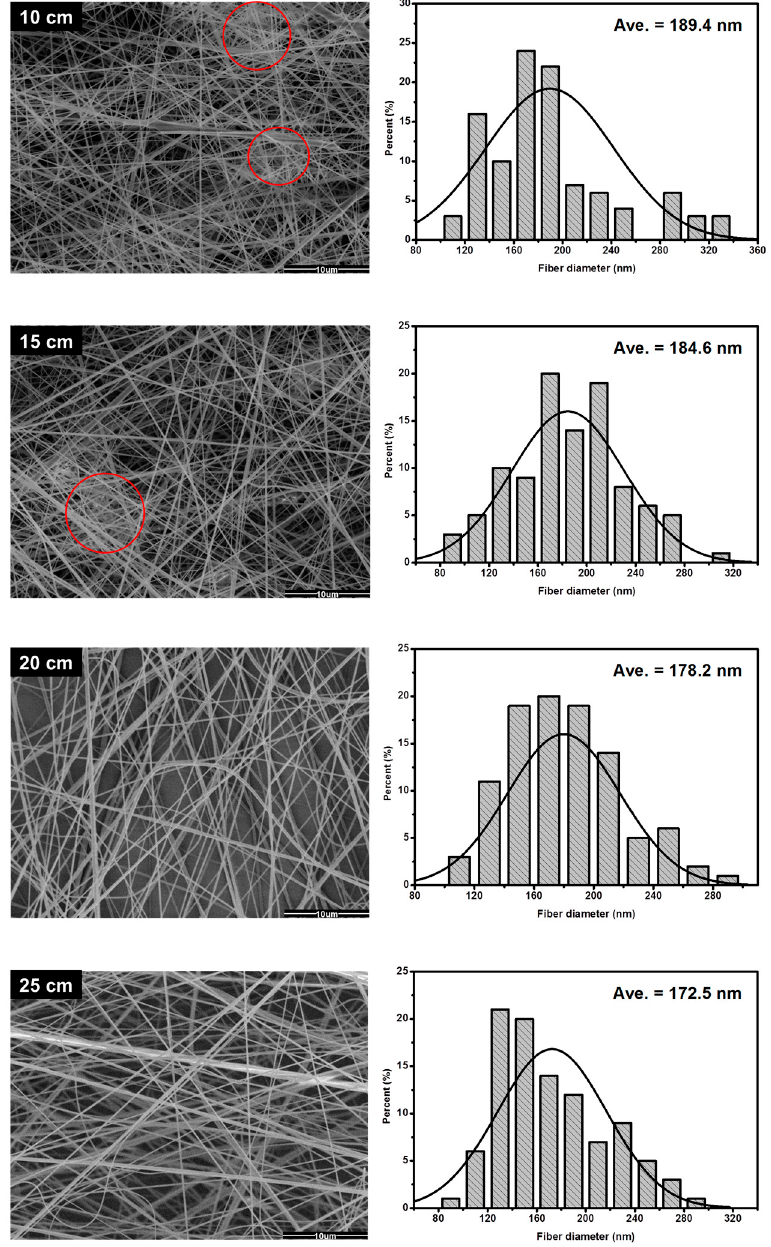
Figure 5. SEM micrographs and diameter distributions of solution blown PAA nanofibers at different receiving distance. PAA concentration, solution feeding rate, gas pressure and inner nozzle diameter were fixed as 8 wt %, 2.4 mL/h, 0.08 MPa and 0.4 mm, respectively.